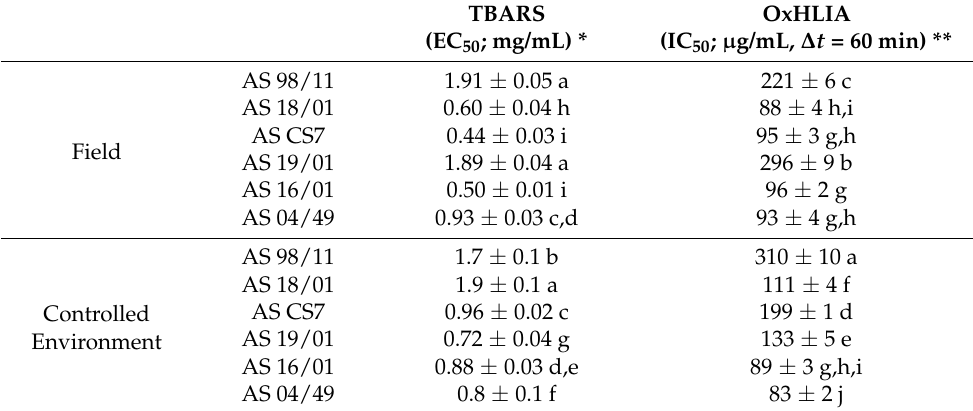
Table 3. Antioxidant activity of hydromethanolic extracts of the studied Agaricus subrufescens samples produced in the field and in controlled environment crops.